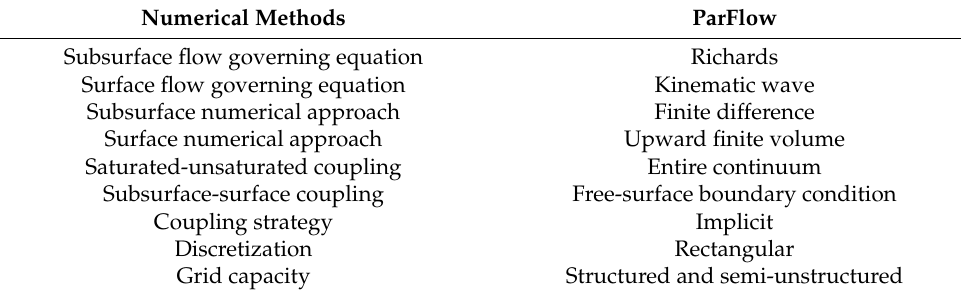
Table 1. A summary of ParFlow.